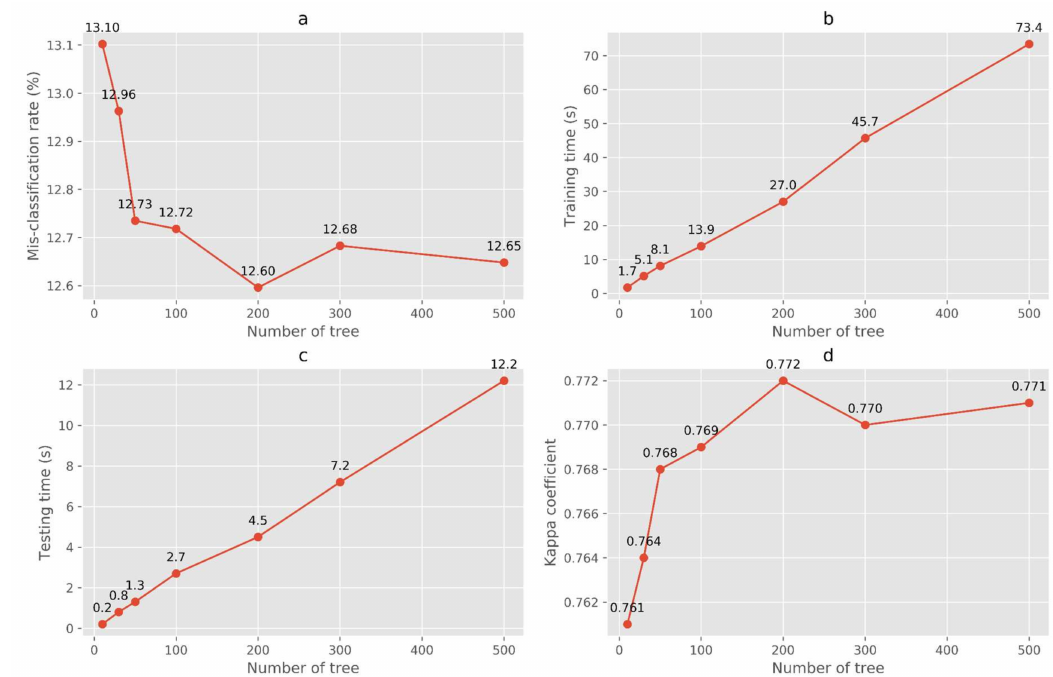
Figure 3. Number of trees optimizing for CCF model: mis-classification rate ( a ), computation time ( b and c , the training and testing times are the computation time measured for the training and testing phases, respectively), and Kappa coe ffi cient ( d ) using data described in Table 3.